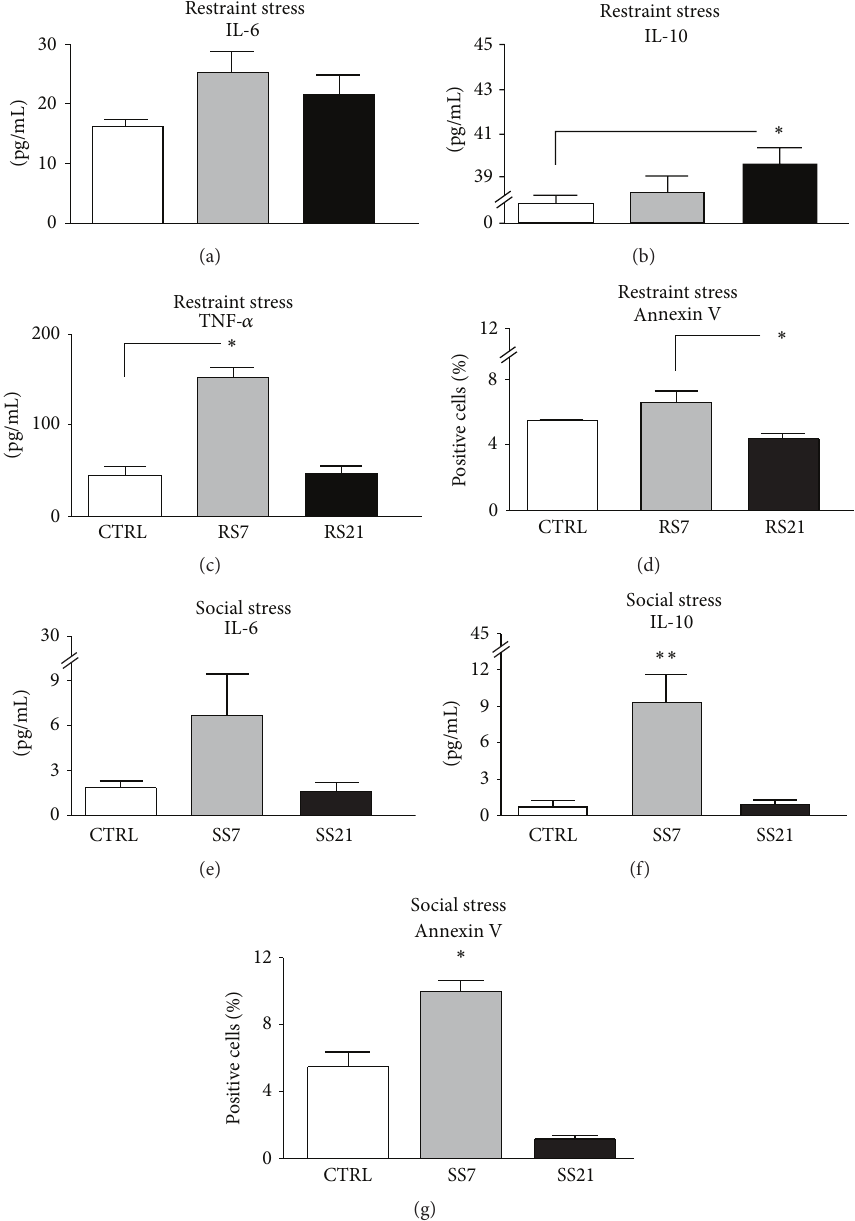
Figure 3: Effect of RS and SS on the immune system response. Restraint stress procedure . Following 7 days of restraint stress the proinflammatory cytokine TNF- 𝛼 increases, (b) while the increase in IL-6 during days 7 and 21 just missed statistical significance (a); by contrast the anti-inflammatory cytokine IL-10 increased following 21 days (c). The percentage of apoptotic splenocytes was found to be decreased following 21 days of stress (d). Social stress procedure . Levels of IL-10 were increased already after 7 days of the SS procedure (f). Splenocytes apoptosis was increased after 7 days of SS and decreased following 21 days (g). No difference is evident as for levels of IL-6 (e). Results are presented as mean + S.E.M. ∗∗ 𝑃 < 0.01 , ∗ 𝑃 < 0.05 .